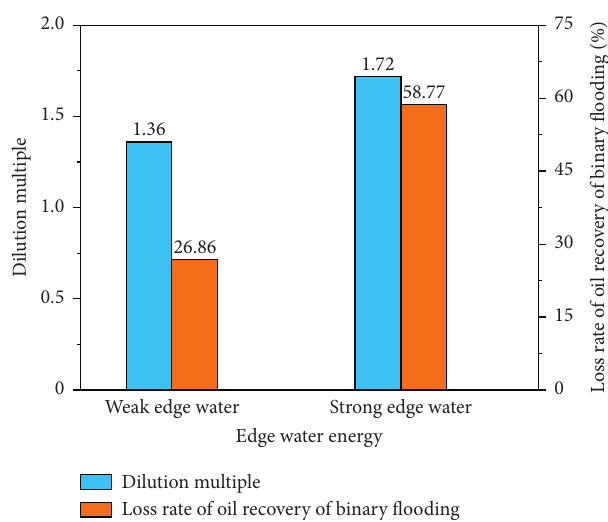
Figure 16: Effect of the edge water energy on the development effect of polymer/surfactant binary